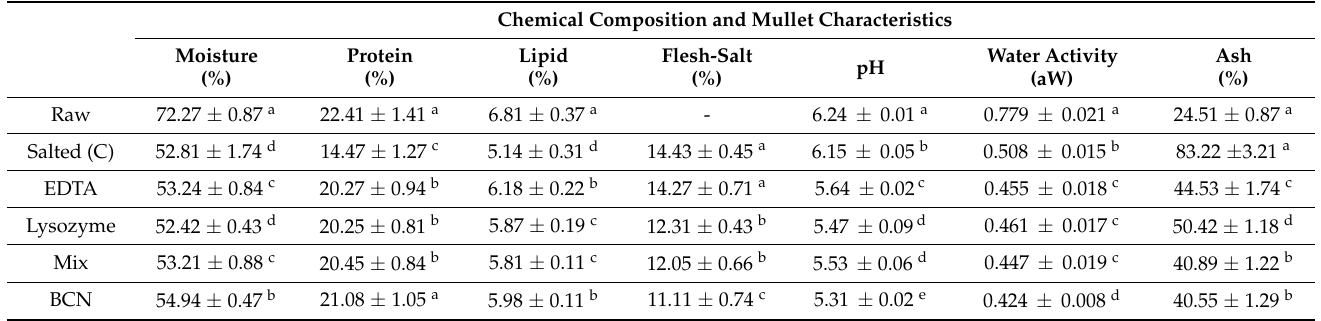
Table 1. Chemical composition of investigated mullet